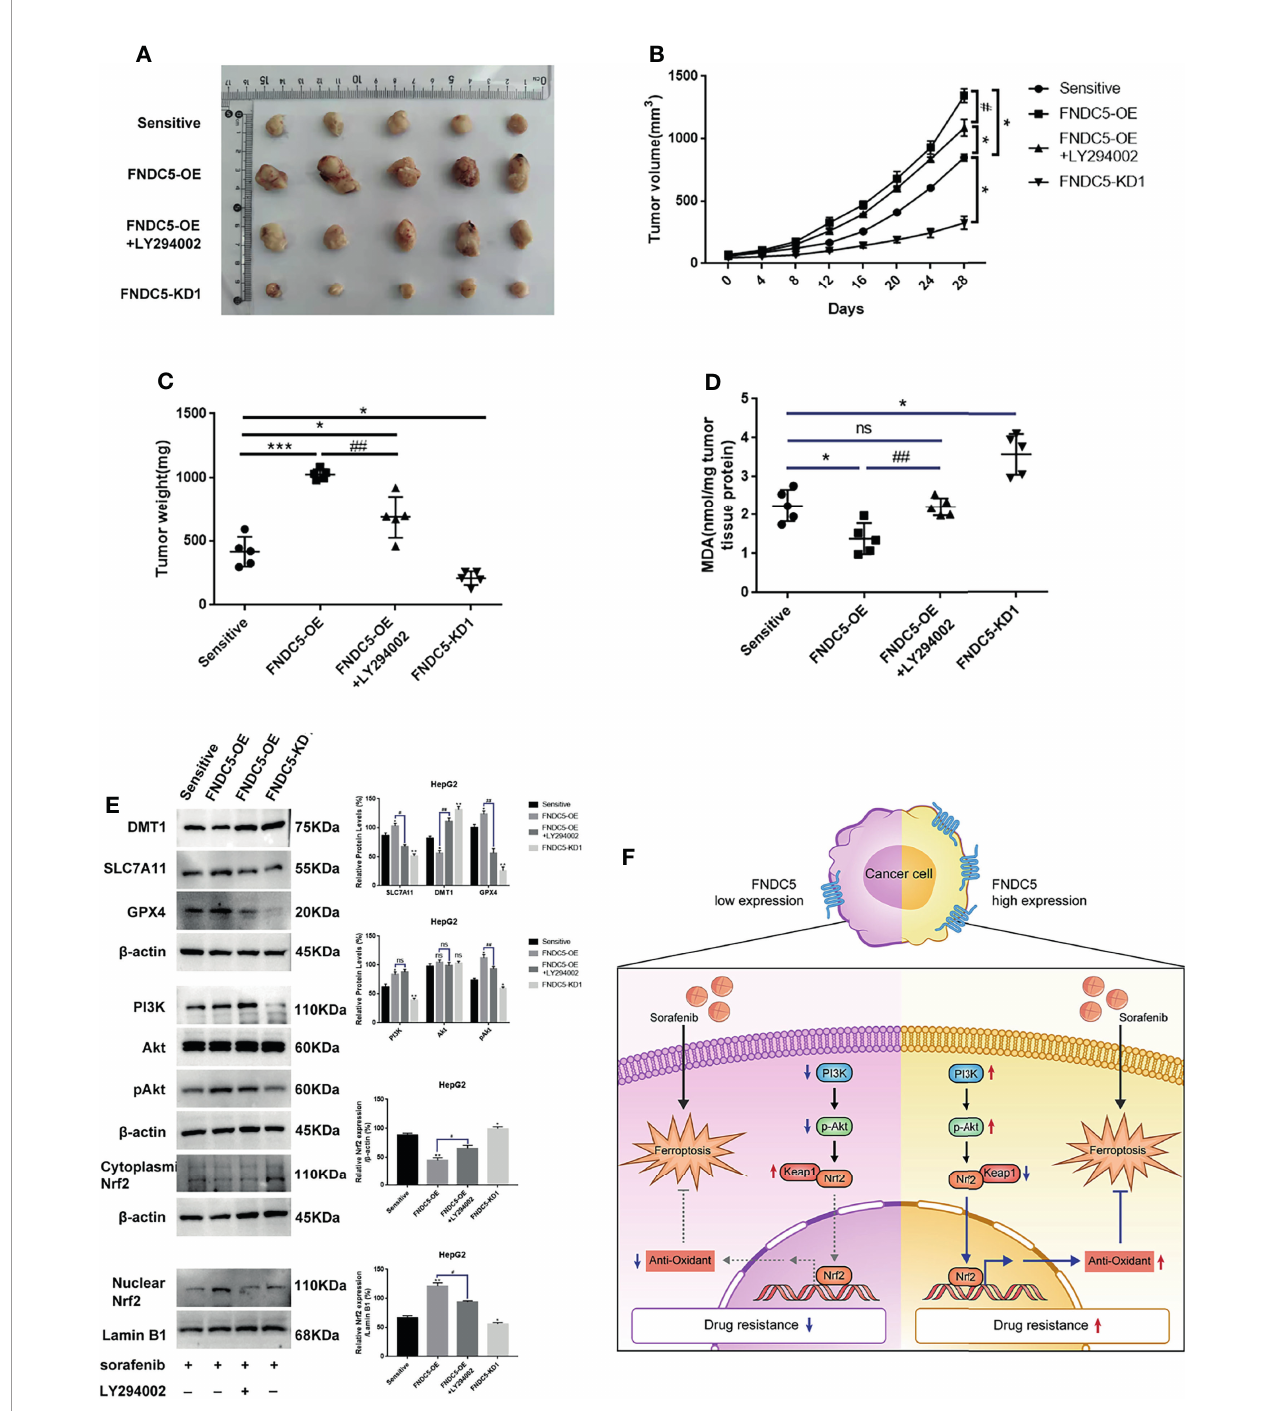
FIGURE 7 | Alterations in the levels of expression of FNDC5 can affect sorafenib-induced ferroptosis in HCC cells in vivo . Animals were divided into four groups according to the expression level of FNDC5 and whether or not they were treated with LY294002; all groups were treated with sorafenib. (A – C) . Tumor volume in each group was measured every 4 days and fi nal tumor weight was measured. (D) The level of MDA in tumor tissues in each group was measured. (E) Western blotting for detecting the expression level of ferroptosis markers and Nrf2-associated pathway proteins in tumor tissues in each group. (F) Illustration